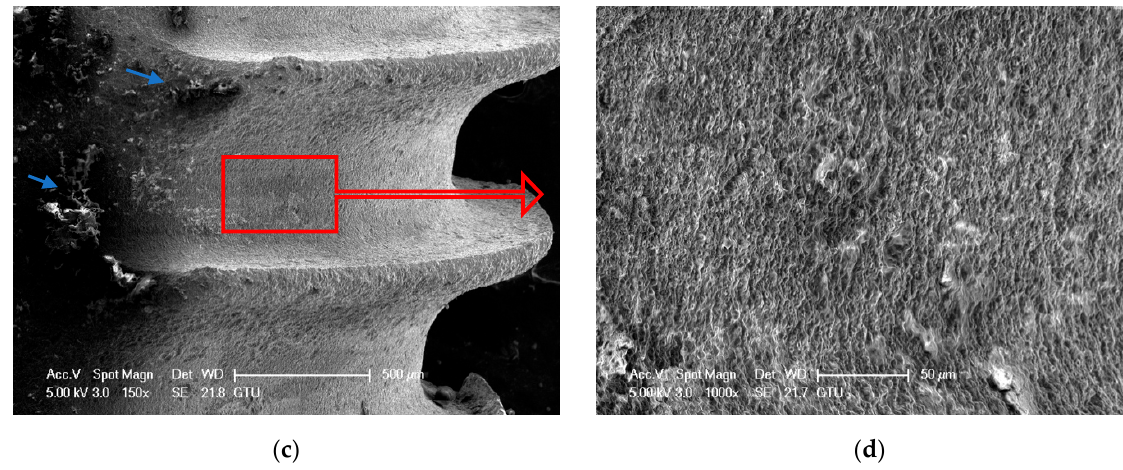
Figure 2. ( a , b ) SEM images showing the topography untreated failed implant surfaces in US-PEEK group (150× and 1000×). The image in ( b ) represents the contamination layer on the implant surface in all SEM images; ( c , d ) after intervention (150× and 1000×). The blue arrows point to PEEK material remnants. Red arrows show the further magnification area.